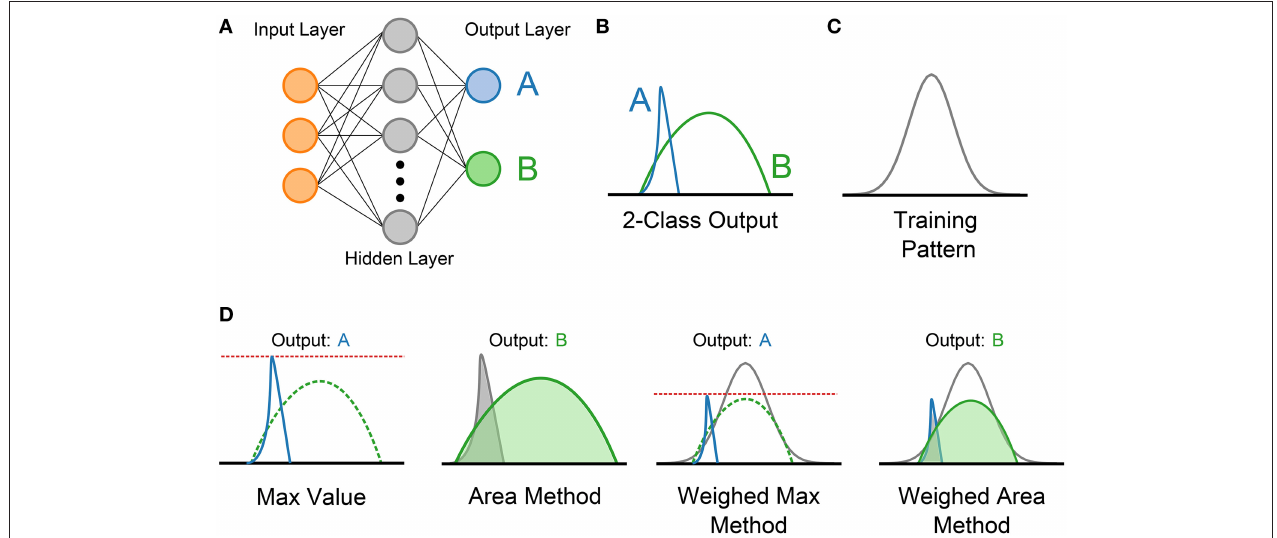
FIGURE 3 | Diagram showing the four output determination methods evaluated for use in multi-class SKIM problems. (A) An example SKIM network with two simultaneously trained output neurons coding for two classes; (A,B). (B) Example outputs from the two output neurons during the period in which the training pattern occurs. In this example, the training utilized is the Gaussian training pattern shown in (C) . Diagrams showing the manner of calculating the four output selection methods are presented in (D) , and include a label showing the theoretical winning class in each case. Note that for the Weighted Sum and Weighted Area methods, the training pattern is also